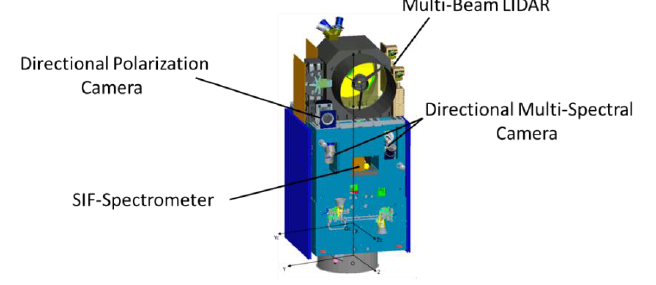
Figure 1. The TECIS-1 satellite layout.